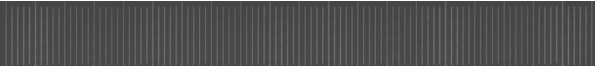
Fig. 6. Result of the registration process of a 1 mm